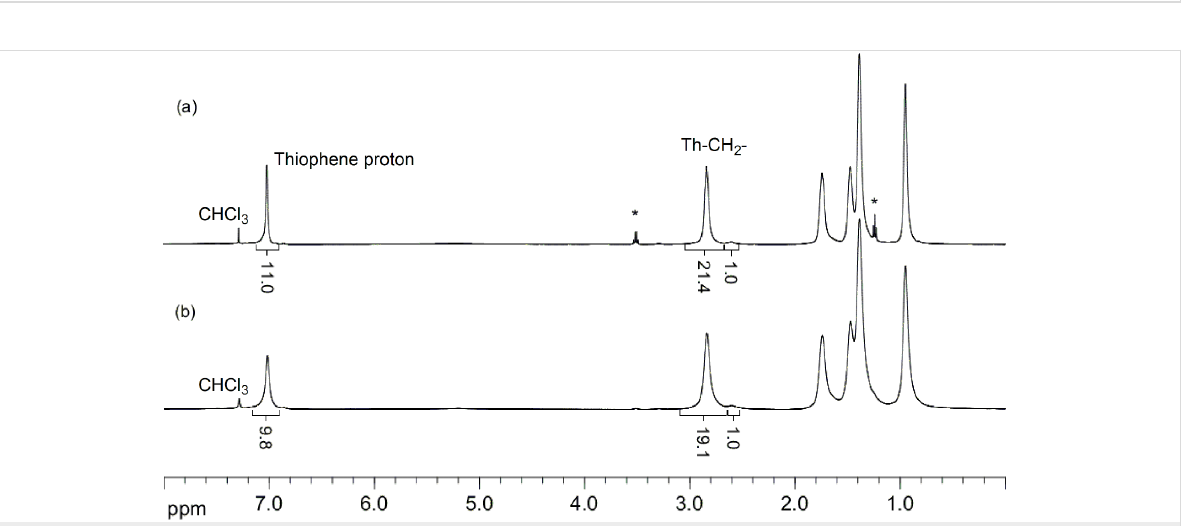
Figure 4: 1 H NMR (CDCl 3 , 500 MHz) spectra of P3HT samples prepared in (a) flow and (b) batch show comparable regioregularity of approximately 95% for both processes. P3HT prepared in flow ( M n = 20 kg/mol) and in batch ( M n = 17 kg/mol) (* designates residual solvent).